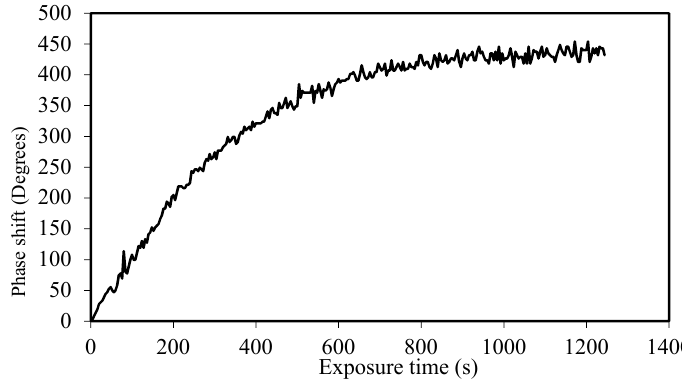
Figure 7. Phase shift as a function of exposure time for a 30-µm thickness material.